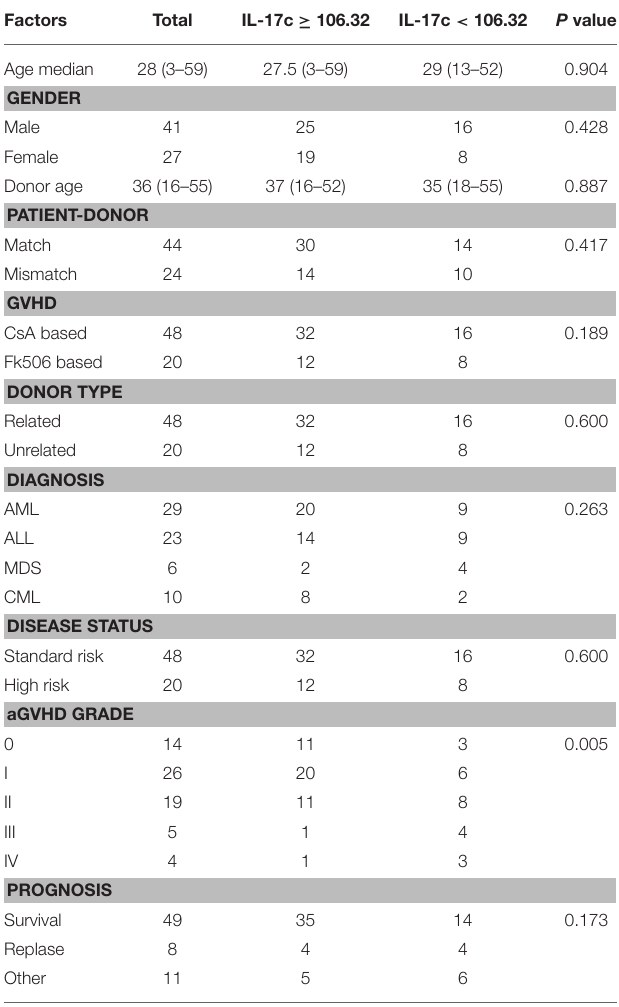
TABLE 1 | The association of IL-17C levels at pre-conditioning with clinical factors.